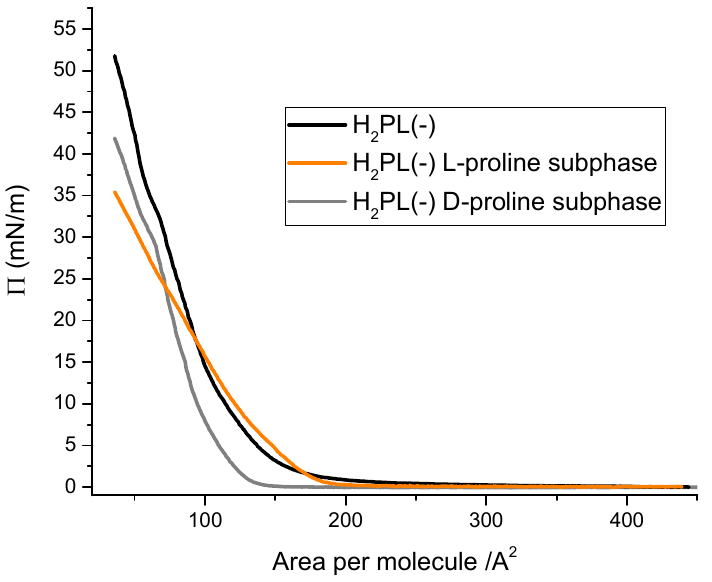
Figure 2. Surface pressure vs. area per molecule curves for porphyrin derivative dissolved in dichloromethane (10 −4 M) and spread at the air–aqueous interface in presence of 10 −5 M L-proline (orange line) and D-proline (gray line).